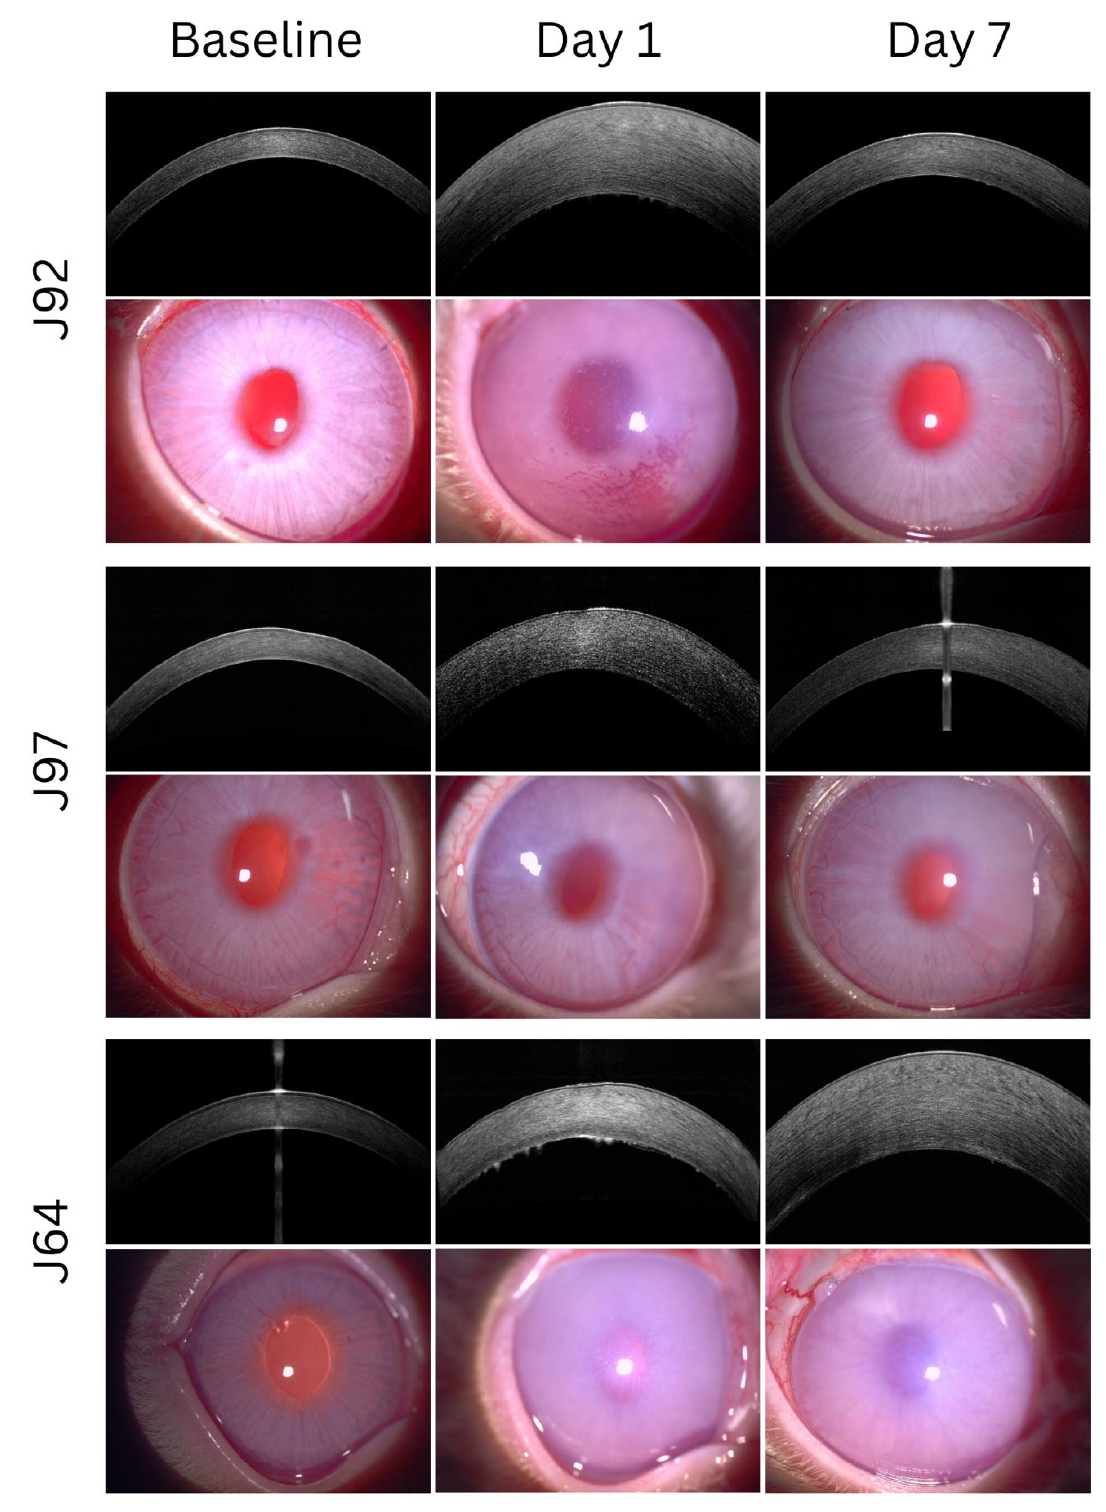
Figure 1. AS-OCT and slitlamp images of three animal eyes. J92 is a representative image set of successful deturgescence with cell visibility on day 1 and corneal clearing by day 7. J97 is a representative image set of successful deturgescence with no cell visibility on day 1, and corneal clearing by day 7. J64 is a representative image set of unsuccessful deturgescence with cell visibility on day 1.